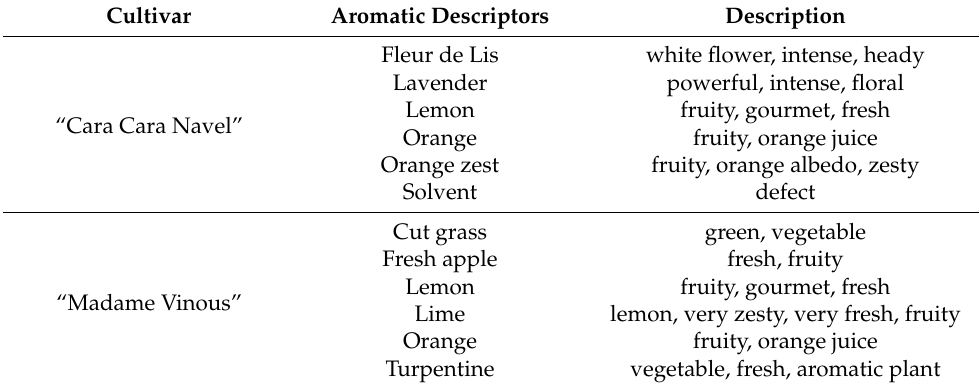
Table 1. Aromatic descriptors of sweet orange PEO and their descriptions. Cultivar Aromatic Descriptors